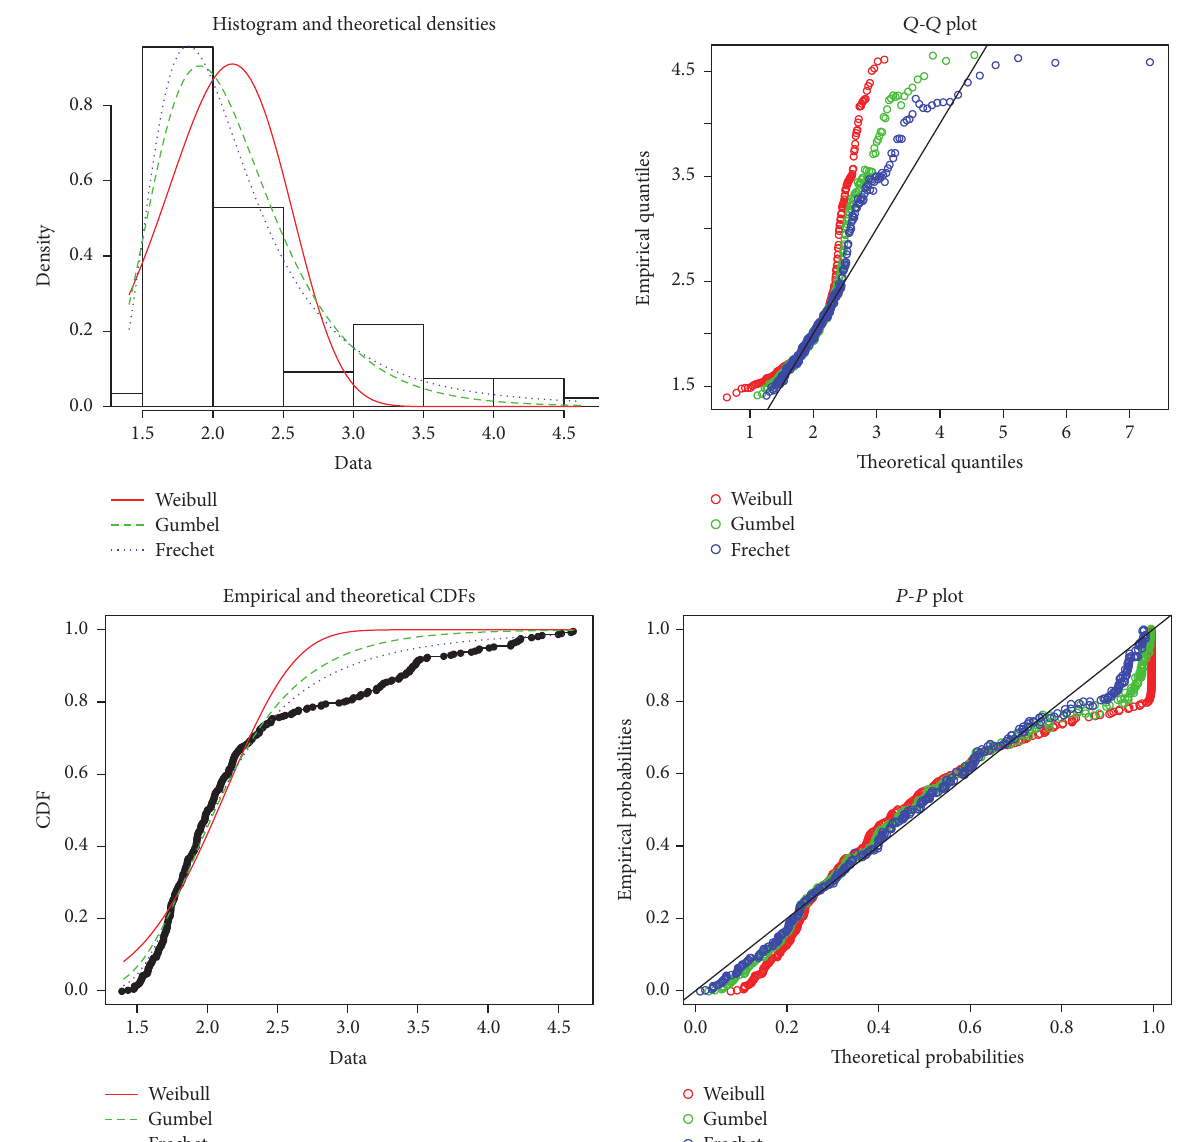
Figure 8: Monthly average wind speeds fitted to the GEV class of